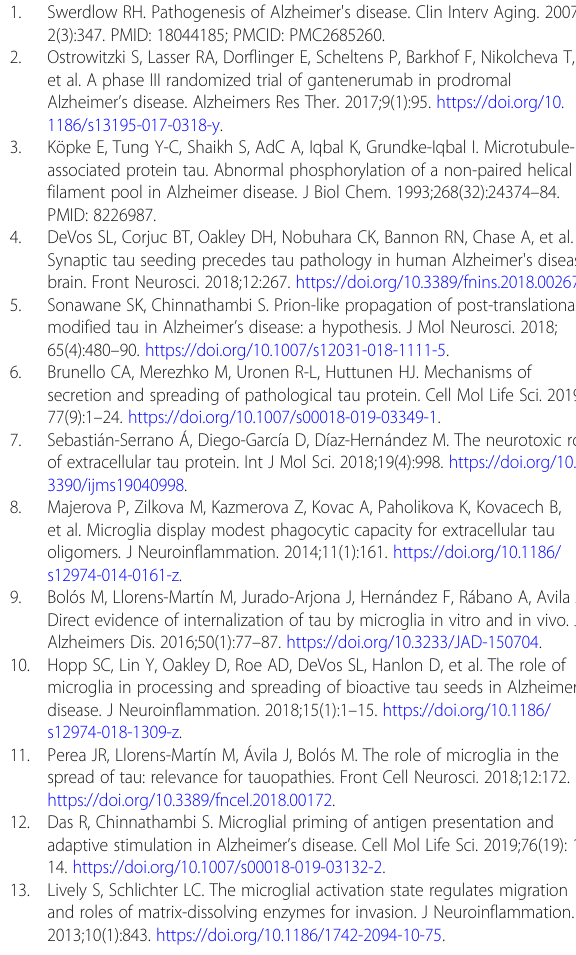
Additional file 1: Figure S1. α -Linolenic acid enhances membrane ruf- fling in microglia. Figure S2. α -Linolenic acid induces actin